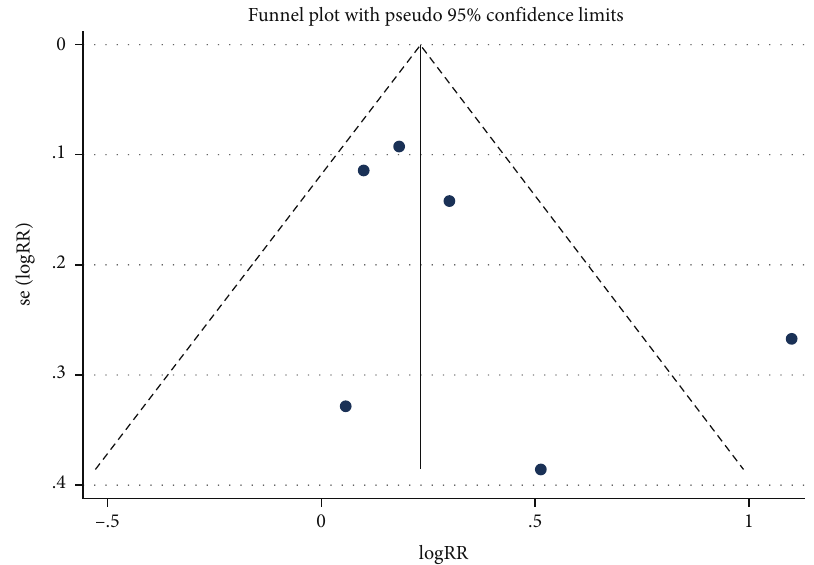
Figure 7: Funnel plot of the total e ff ective